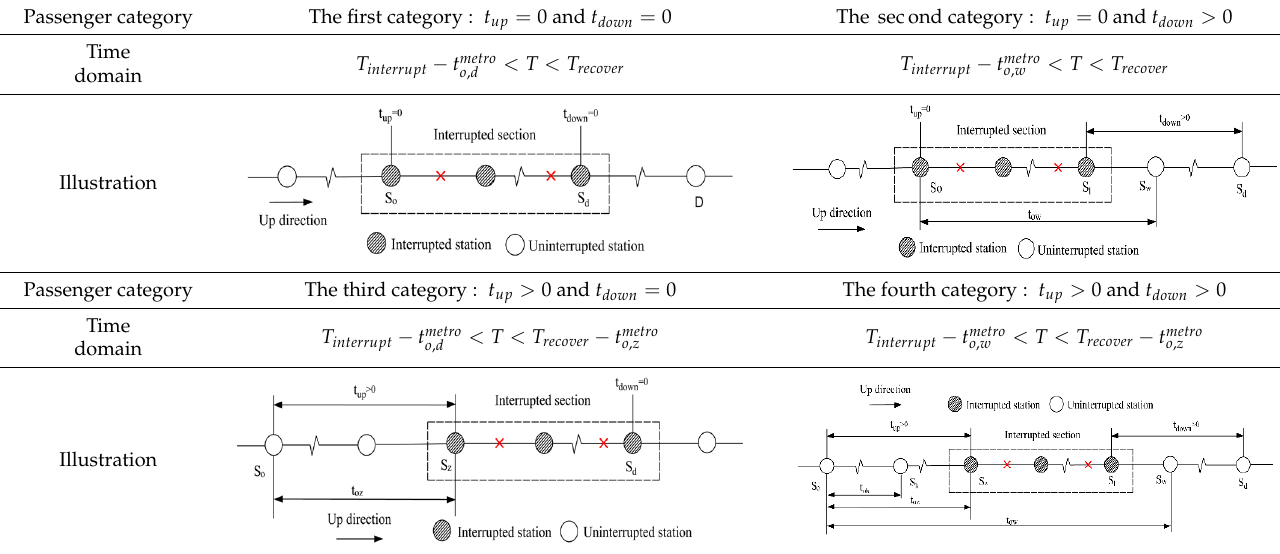
Table 1. The tap-in time domains of affected non-transfer passengers.